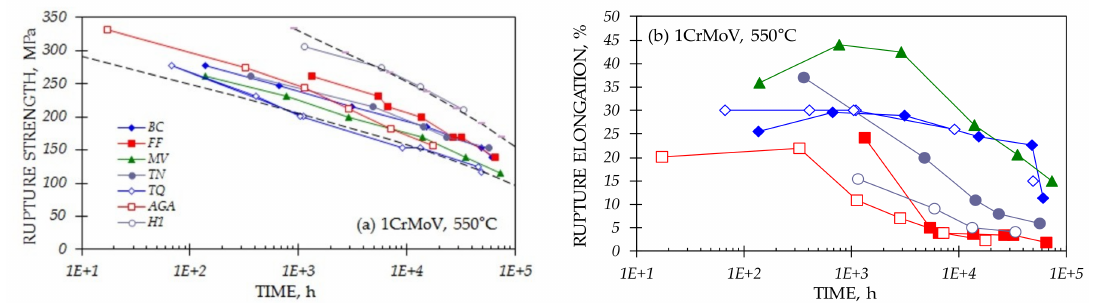
Figure 7. Variation of ( a ) rupture strength, and ( b ) rupture ductility, for different heats (casts) of 1CrMoV at 550 ◦ C (only a small number of heats (casts) are shown from a much greater database to illustrate the variability trends